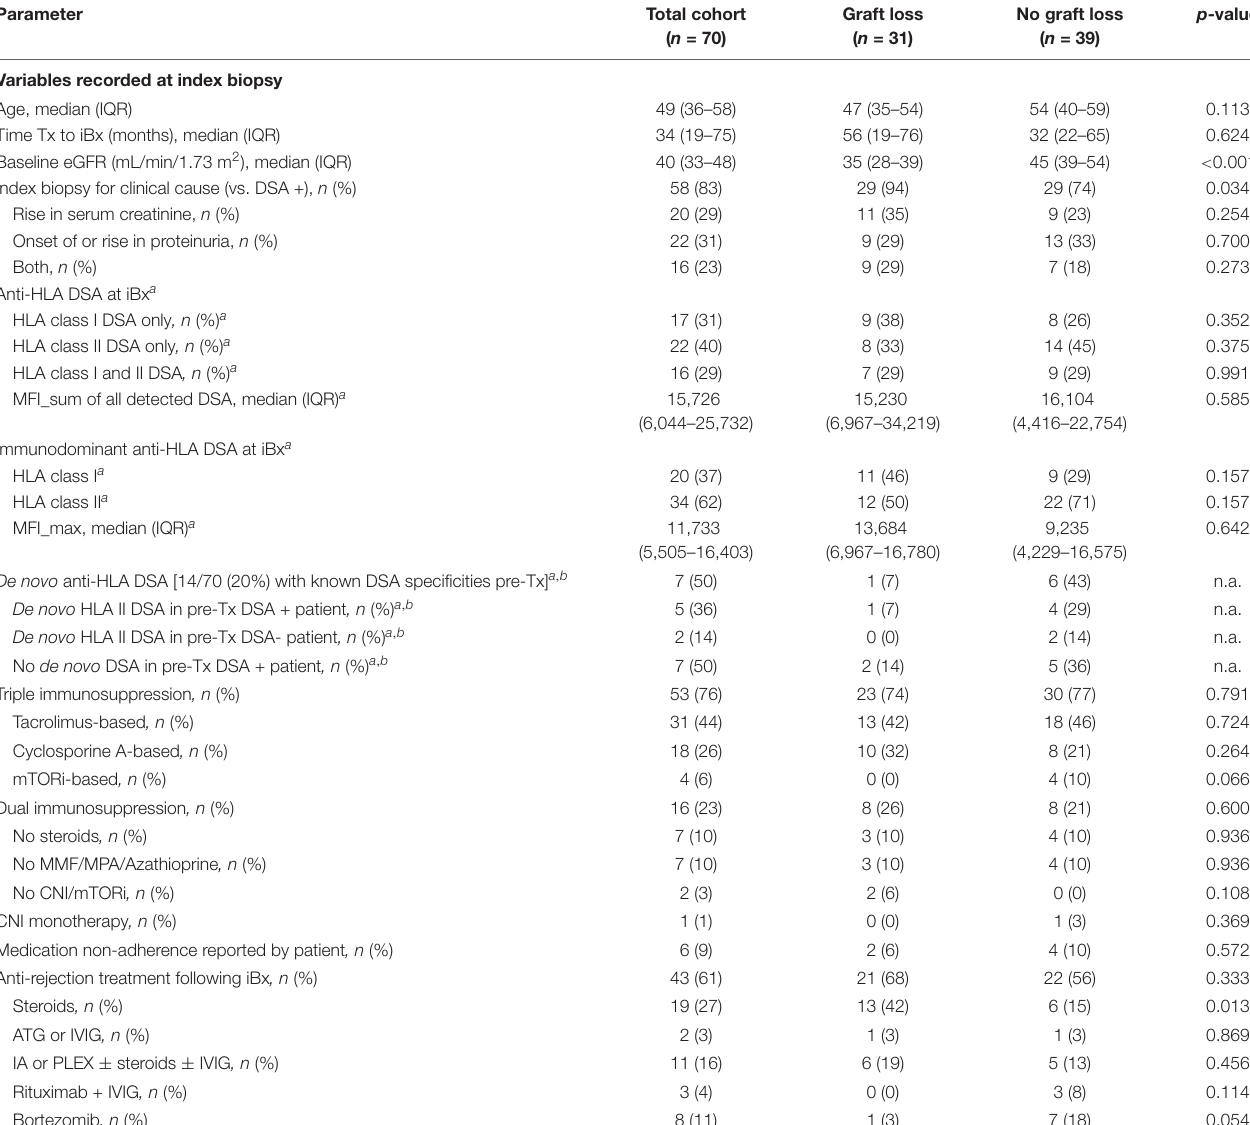
TABLE 2 | Variables recorded at index